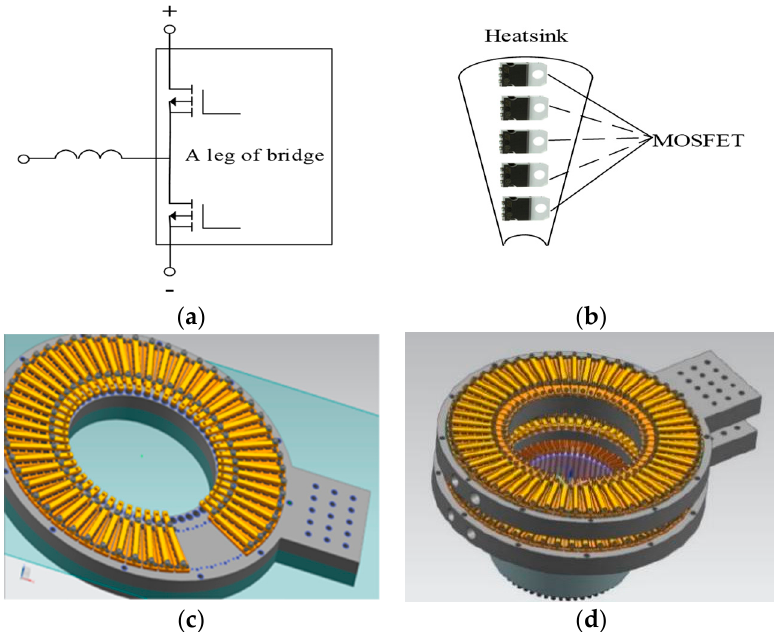
Figure 1. Schematic models of the rectifier module and the power generation system: ( a ) A leg of bridge; ( b ) heat sink; ( c ) schematic of the confluence plate; ( d ) schematic model of a large DC power generation system.